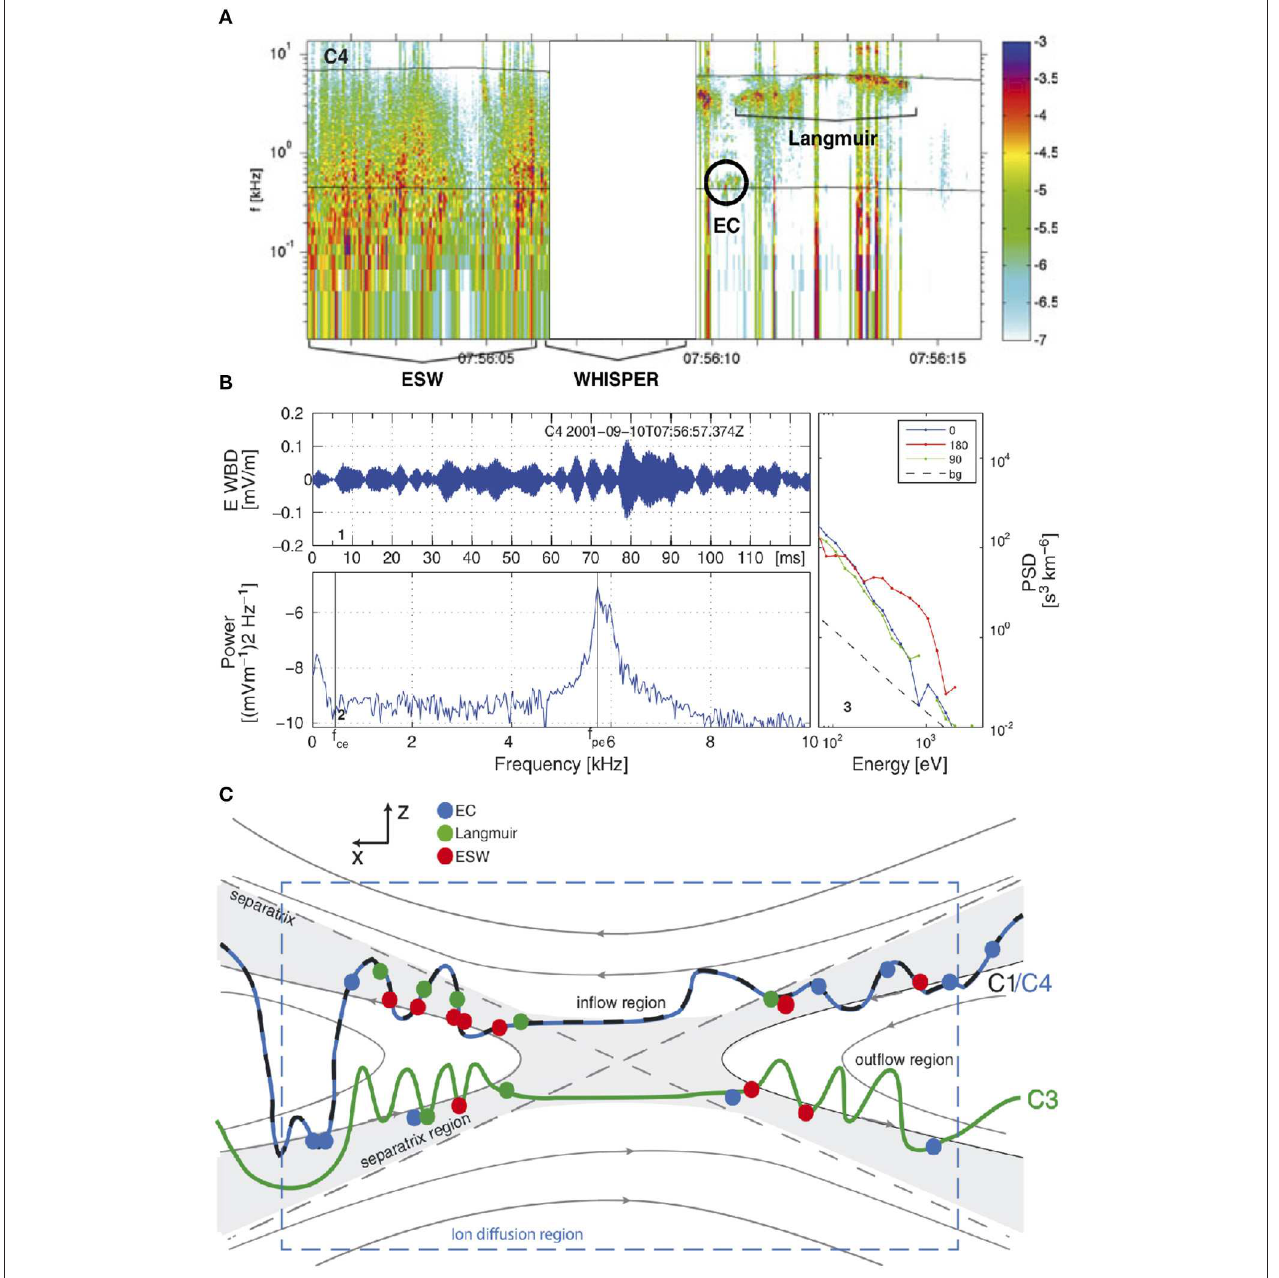
FIGURE 1 | Example of waves observed in the separatrix of magnetotail reconnection observed by Cluster from Viberg et al. (2013). (A) Electric field spectrogram showing ESWs, EC waves, and Langmuir waves. (B) Example of Langmuir waves: 1 Waveform of Langmuir waves, 2 Power spectrum, and 3 electron phase-space densities at pitch angles 0 ◦ (blue), 90 ◦ (green), and 180 ◦ (red). (C) A schematic showing the paths of the Cluster spacecraft across the reconnection region and locations of the observed ESWs, EC waves, and Langmuir waves.